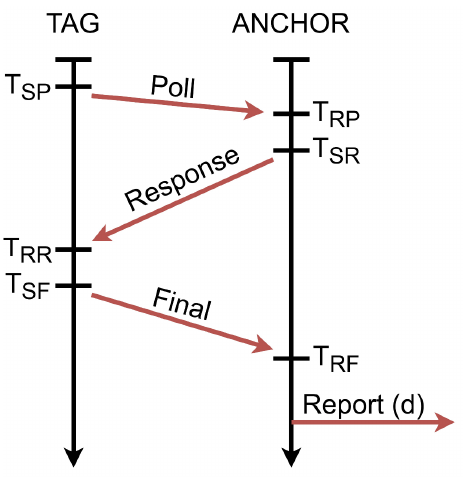
Figure 2. Diagram of communication between the tag and the anchor.